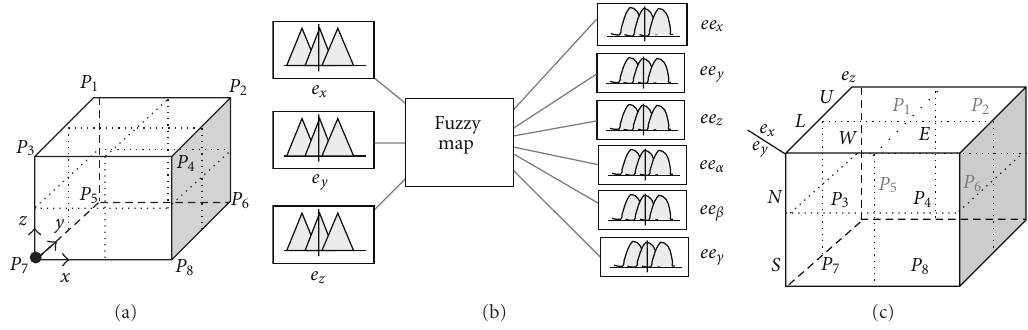
Figure 4: Definition of the fuzzy interpolation inference